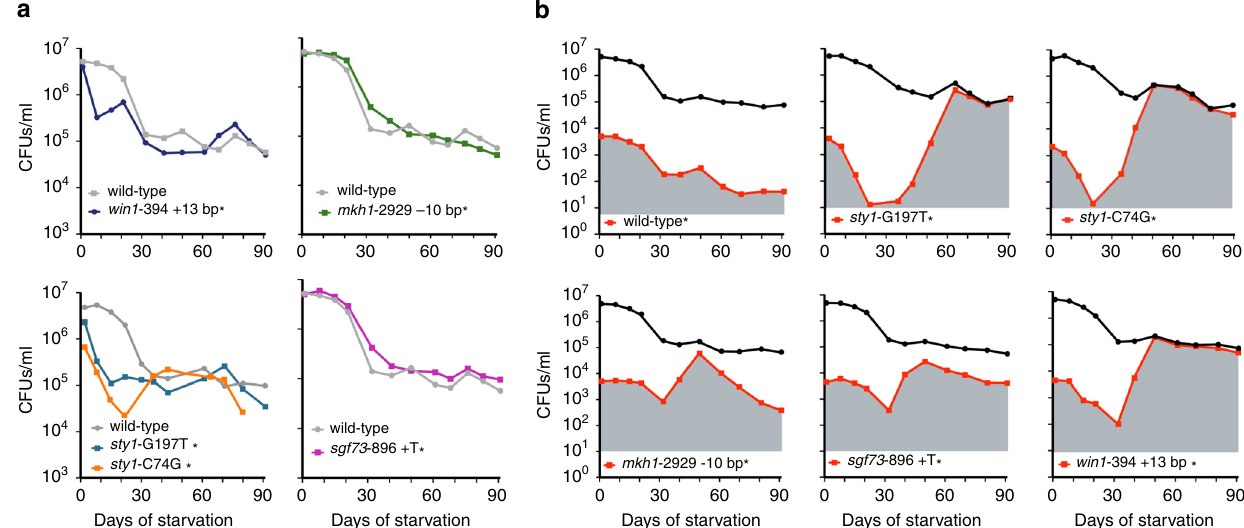
Fig. 5 Survival behavior of the mutants depends on the environment. a Survival of single mutants (colony-forming units) with their wild-type control during long-term starvation. The star (*) indicates the presence of the kanamycin marker in the background. Source data are provided as a Source Data fi le. b Co-cultures where the wild-type is contaminated at day 1 of quiescence with 0.1% of the indicated strain (*) marked with the kanamycin gene (red). The black curve indicates the viability of the entire population, while the red one reveals the colony-forming units of the kanamycin-resistant strain in this population. Each point corresponds to the mean of independent cultures ( n = 2), except for the sty1 mutants that were only tested once. Source data are provided as a Source Data fi